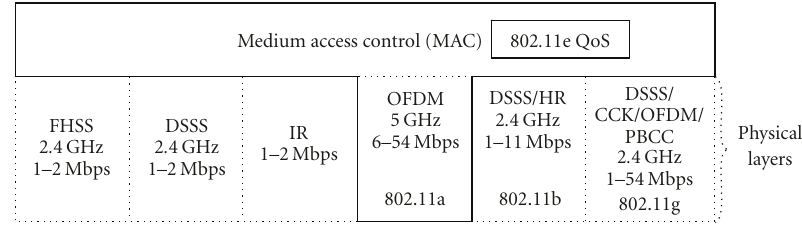
Figure 1: An overview of the WLAN family 802.11, showing in bold which parts that 802.11p will use and modify.